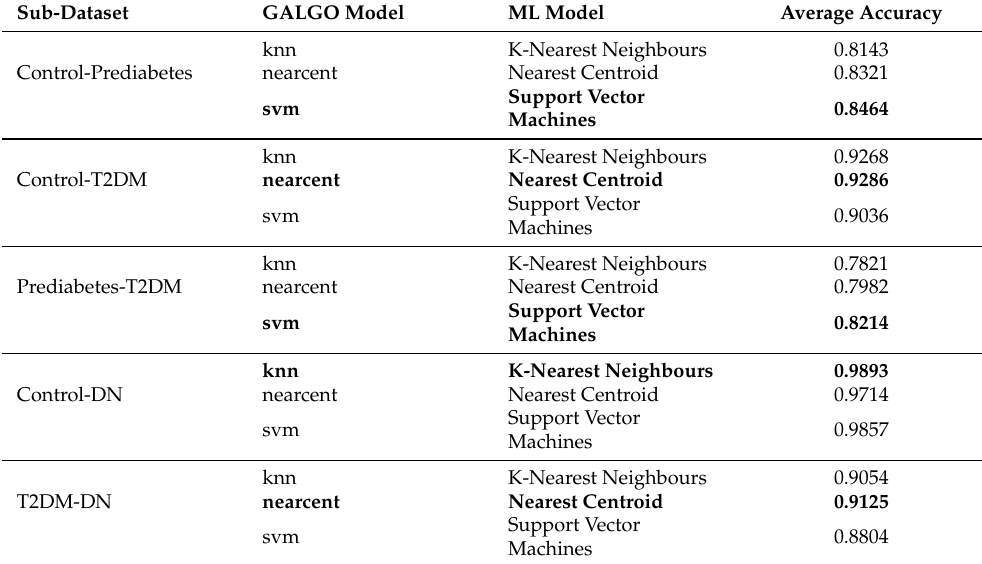
Table 5. GALGO models—Average